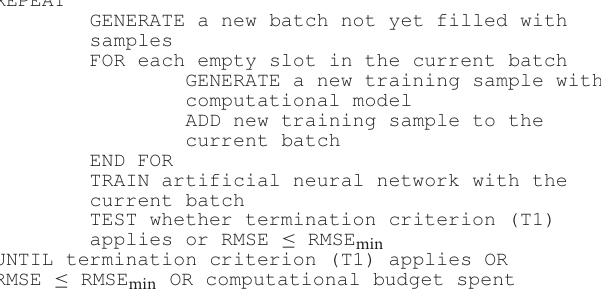
TABLE 1 | Pseudocode for single-fidelity training. REPEAT GENERATE a new batch not yet filled with samples FOR each empty slot in the current batch GENERATE a new training sample with computational model ADD new training sample to the current batch END FOR TRAIN artificial neural network with the current batch